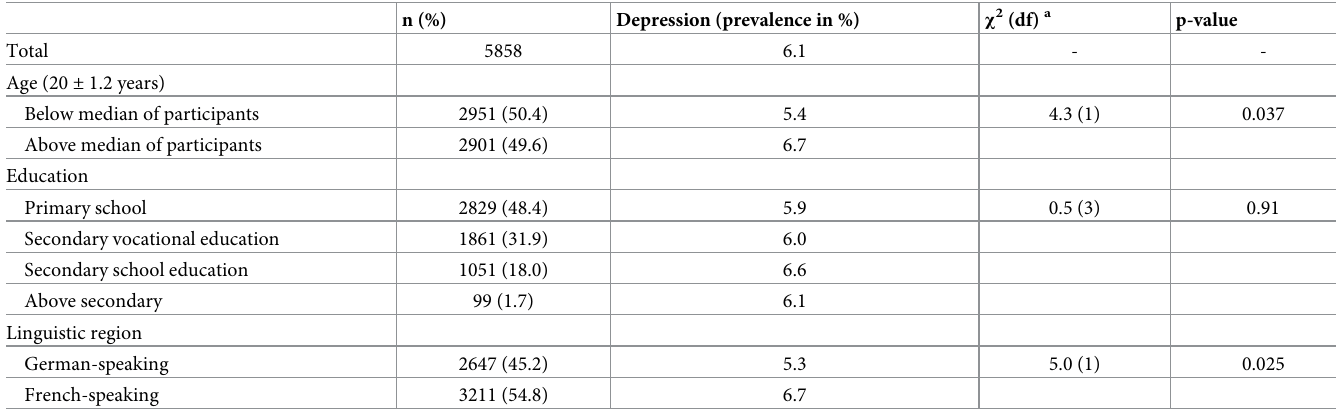
Table 1. Baseline characteristics of study